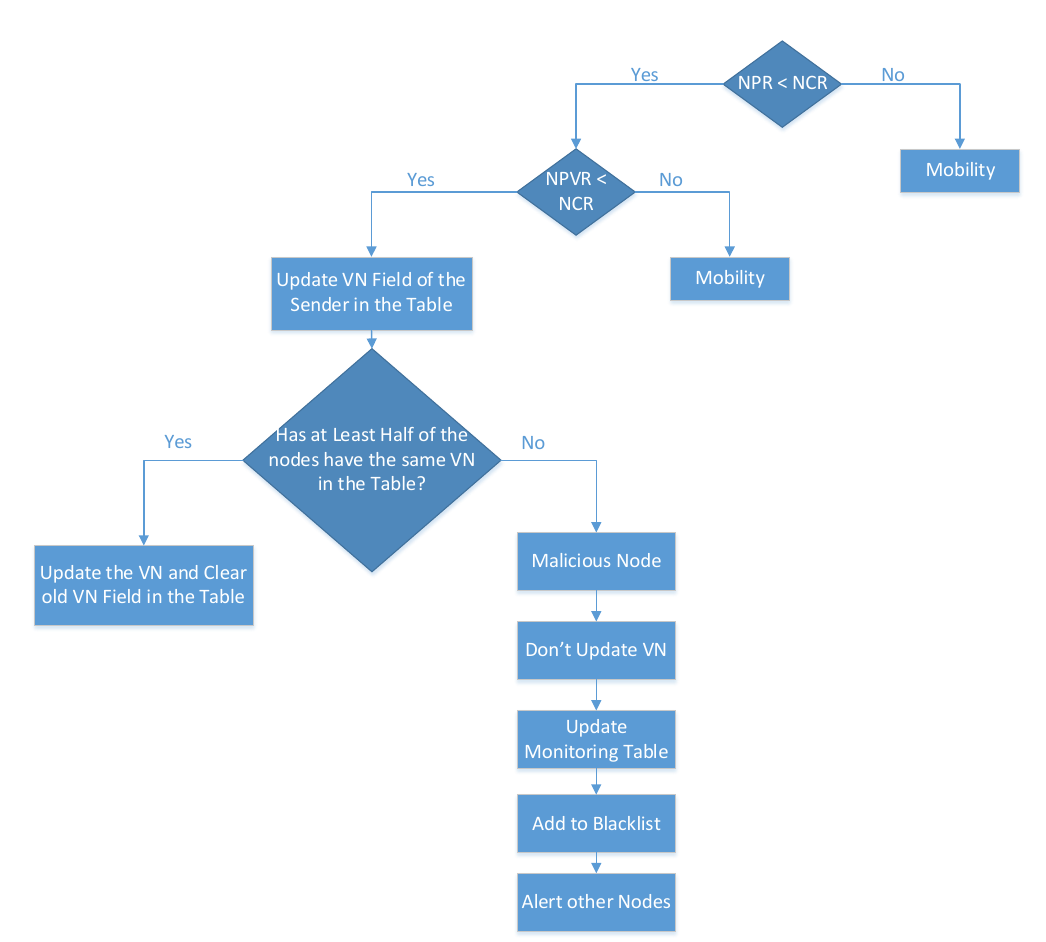
Figure 2. Protocol Model Flowchart, Phase Five.